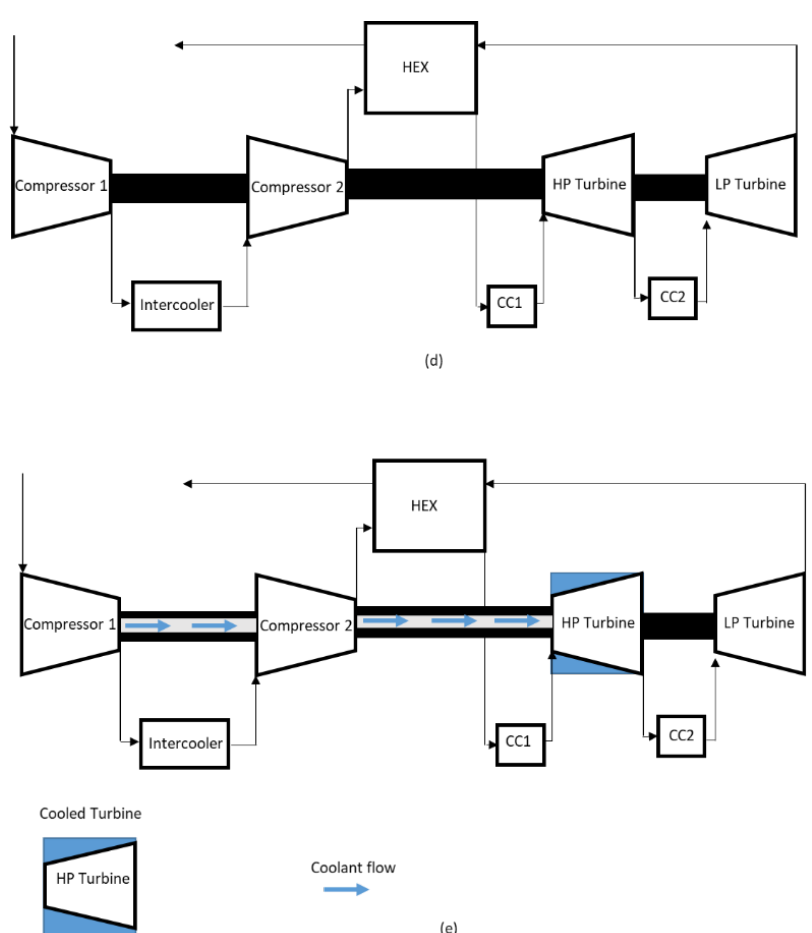
Figure 6. GT configurations from literature: ( d ) IRReGT cycle, ( e ) Intercooled Recuperated Reheated GT cycle with a cooled HP turbine.